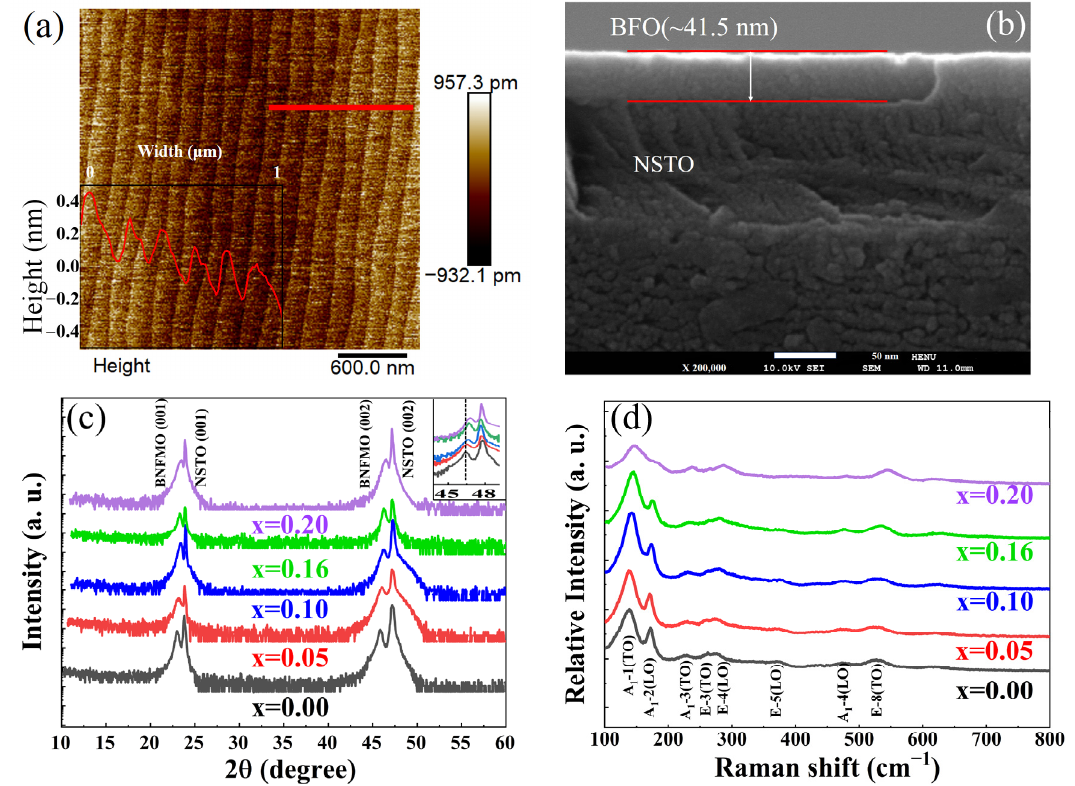
Figure 1. ( a ) Etched topography of NSTO substrate. ( b ) Microscopic SEM cross-sectional image of a Bi 0 . 84 Nd 0 . 16 Fe 0 . 99 Mn 0 . 01 O 3 thin film on a NSTO substrate. ( c ) 2 θ -XRD patterns of Bi 1 − x Nd x Fe 0 . 99 Mn 0 . 01 O 3 /NSTO heterojunctions (x = 0.00~0.20). ( d ) Raman spectra for BNFMO films at room temperature.